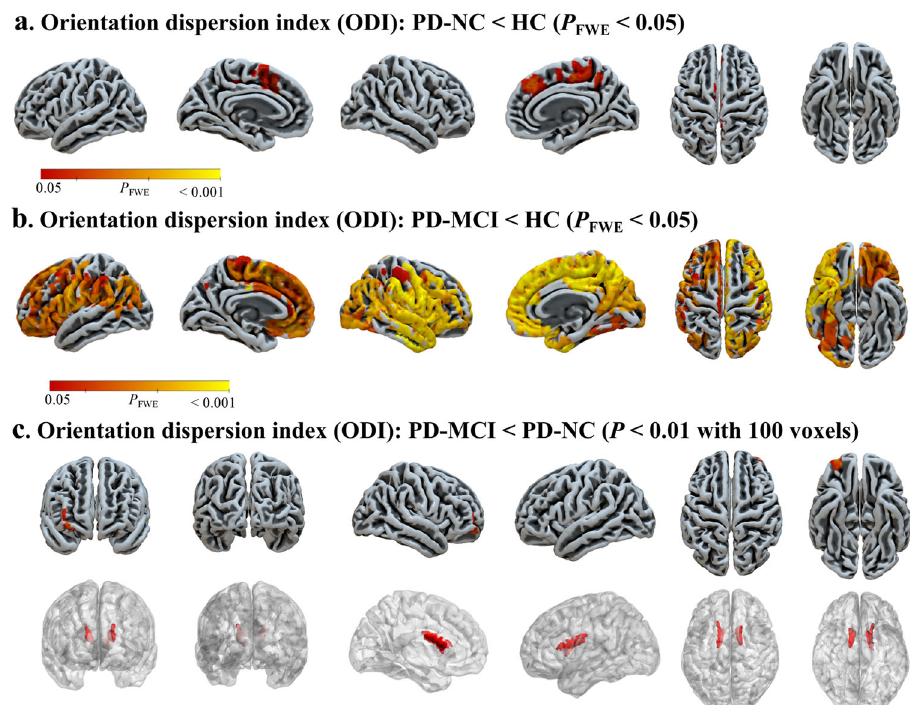
Fig. 1 ODI comparisons among groups. Compared with HC, PD-NC patients showed lower ODI in bilateral cingulate and paracingulate gyri, supplementary motor area, right paracentral lobule and precuneus ( a ); PD-MCI patients showed widespread lower ODI throughout bilateral frontal, parietal, occipital and right temporal areas ( b ). Compared with PD-NC, PD-MCI patients showed reduced ODI in right frontal area and bilateral caudate nuclei for GBSS analyses with cluster-based thresholding method (voxel P < 0.01 and cluster >100 contiguous voxels) ( c ). HC healthy control, PD-NC Parkinson ’ s disease with normal cognition, ODI orientation dispersion index, PD-MCI Parkinson ’ s disease with mild cognitive impairment.